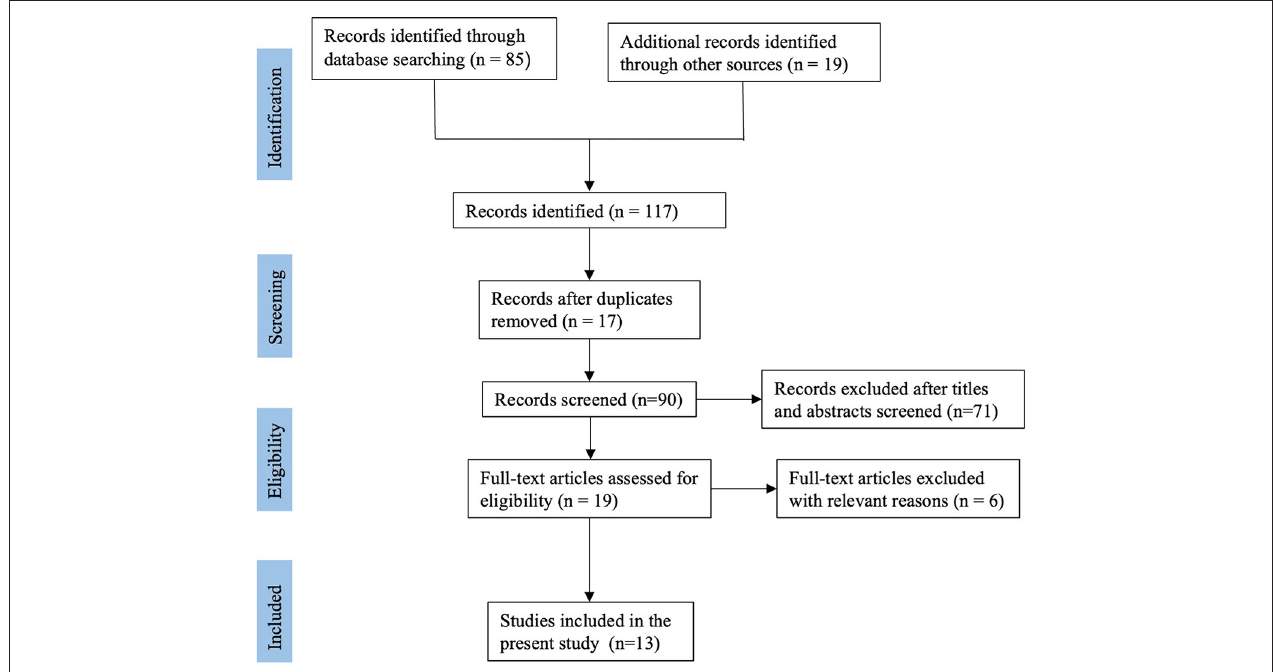
FIGURE 1 | The flow diagram involved in the current